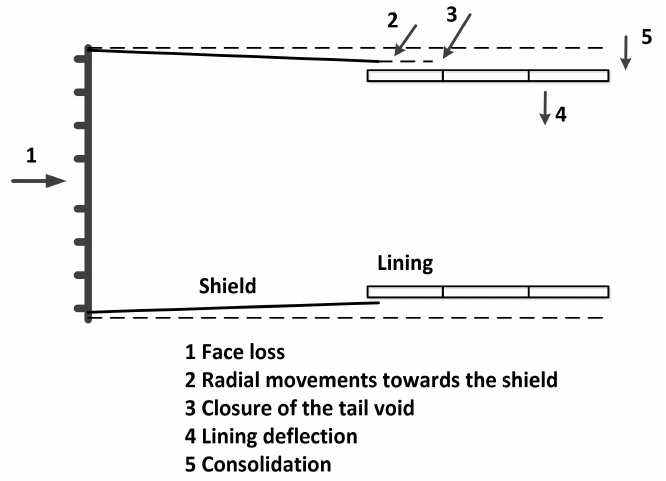
Figure 1. Sources of stratum movements of shield